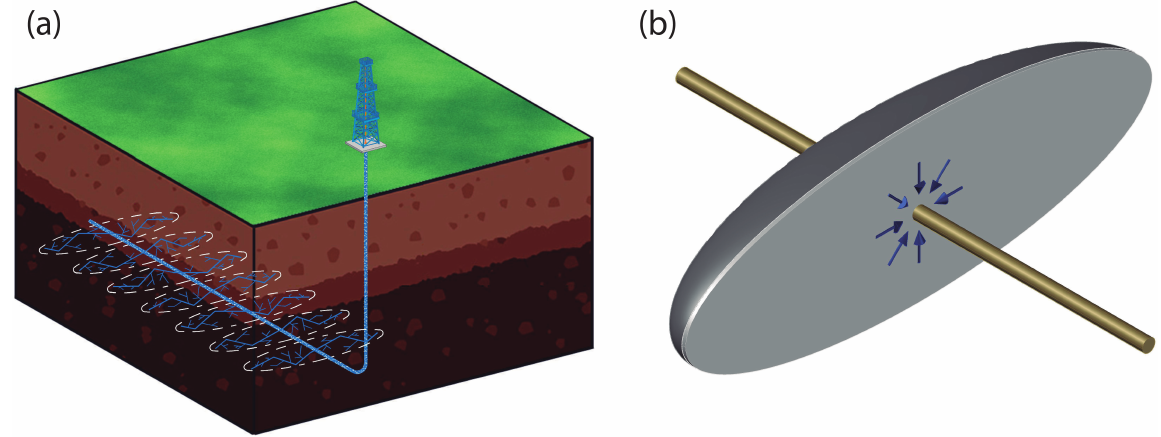
Figure 1. Physical model. ( a ) Schematic depiction of the well. ( b ) Flow in the ellipsoidal EPV. The BCa is configured by a rectangular prism of 1800 m × 600 m × 90 m (SRV), located at 3000 m depth in a shale formation at 30 MPa of pressure and a constant thickness of 90 m. The boundaries of the SRV are considered no-flow